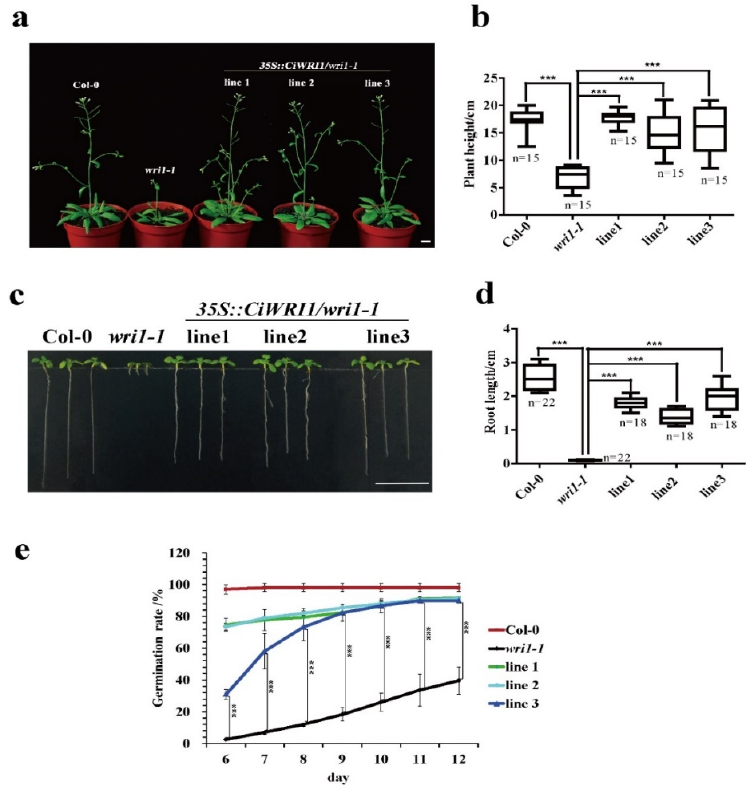
Figure 5. Rescue of developmental defects in wri1-1 mutant by CiWRI1 . ( a ) Plant height in 35-day-old wild type, wri1-1 mutant, and three individual p35 S: CiWRI1 / wri1-1 transgenic plants. ( b ) Quantification of plant heights in ( a ). ( c ) Root length in 12-day-old wild-type, wri1-1 mutant, and three individual p35 S: CiWRI1 / wri1-1 transgenic plants. ( d ) Quantification of root lengths in ( c ). ( e ) Germination rates of wild-type ( n = 5 for each time point, 100 seeds for each biological replicate), wri1-1 mutant ( n = 3 for each time point, 100 seeds for each biological replicate), and three individual p35 S: CiWRI1 / wri1-1 transgenic plants (Line 1, n = 3 for each time point; Line 2, n = 3 for each time point; Line 3, n = 4 for each time point; 100 seeds for each biological replicate). *** p < 0.001, Student’s t test. Bars = 1 cm ( a , c ).